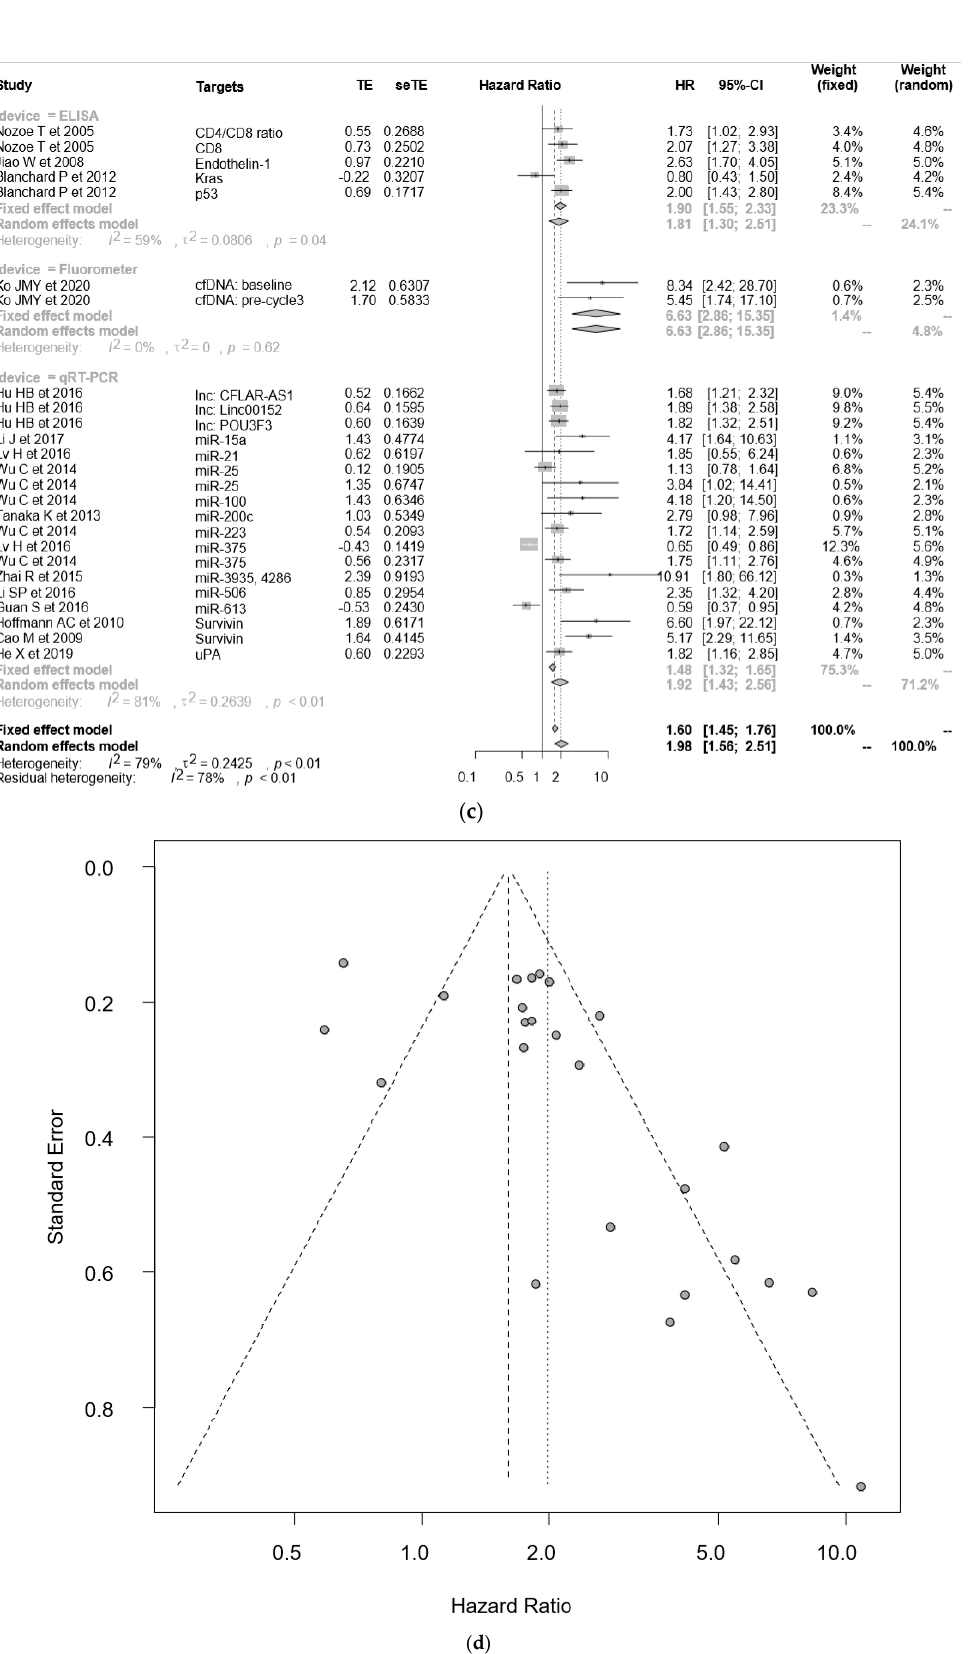
Figure 2. The overall survival (OS) analysis of liquid biopsies. ( a ) Forest plot of the hazard ratio for OS in the cytometric assay; ( b ) funnel plot for the publication bias of ( a ); ( c ) forest plot of the hazard ratio for OS in the non-cytometric assay; ( d ) funnel plot for the publication bias of ( c ).